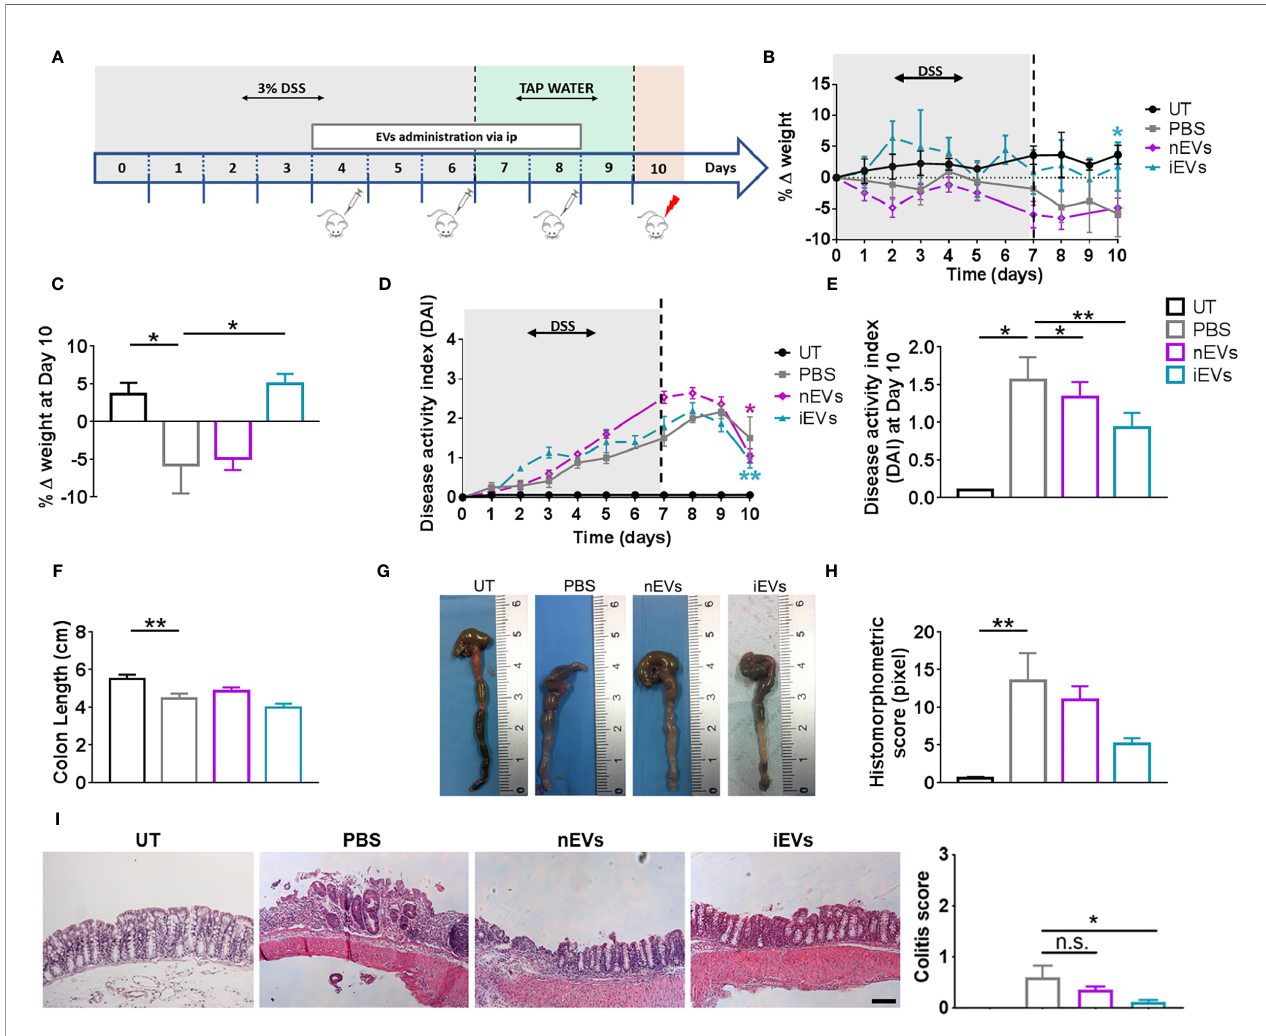
FIGURE 3 | EVs improve the clinicopathological signs of colitis. (A) Experimental design. DSS was given in drinking water for 6 days followed by three days on plain water. EVs were injected intraperitoneally on days 4, 6 and 8. Weight loss (B) , Percent weight loss (C) and disease activity scores (D) were determined daily. (E) Disease activity index at 10 days. Colon length (F, G) , histomorphometric score (H) and colitis score (I) were determined on day 10. Scale bars, 50 m m. Results are mean ± standard error (n = 5). *P < 0.05, **P < 0.01, n.s. = not signi fi